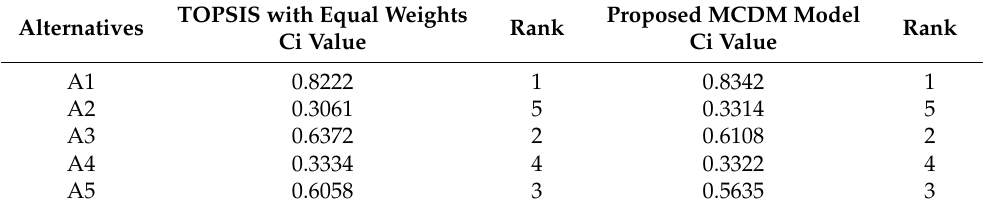
Table 8. Comparing results with TOPSIS with equal weights Ci value.